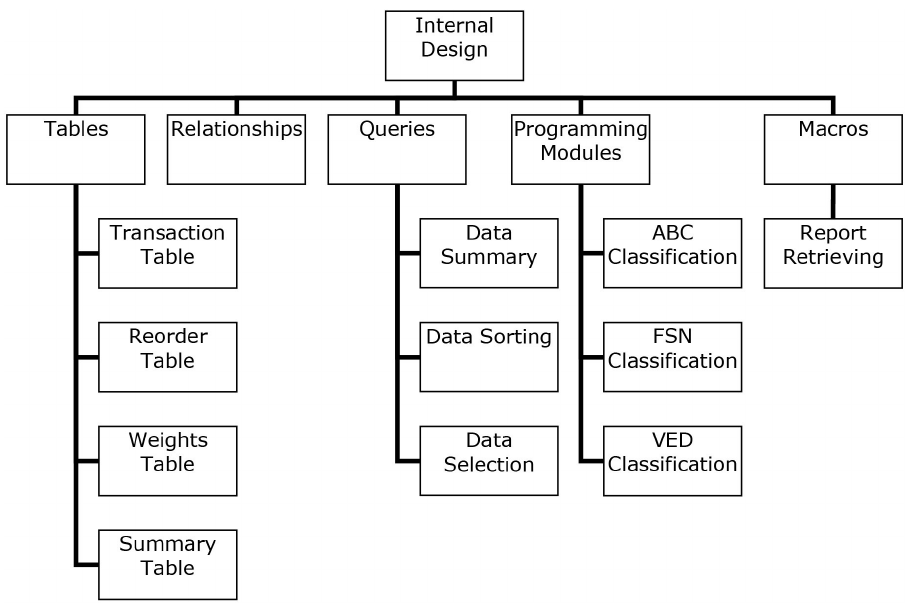
Figure 2. DSS internal